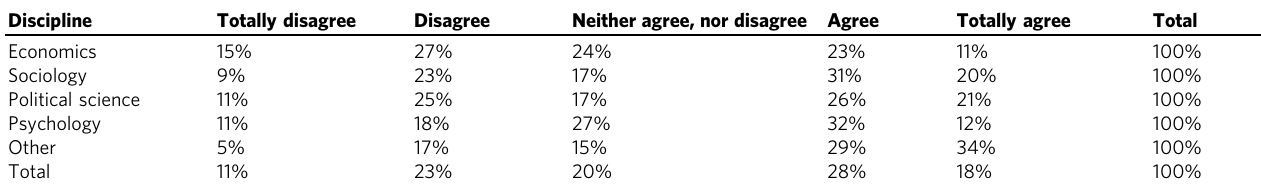
Table 1 The role of literature in the development of research questions and projects by discipline. Discipline